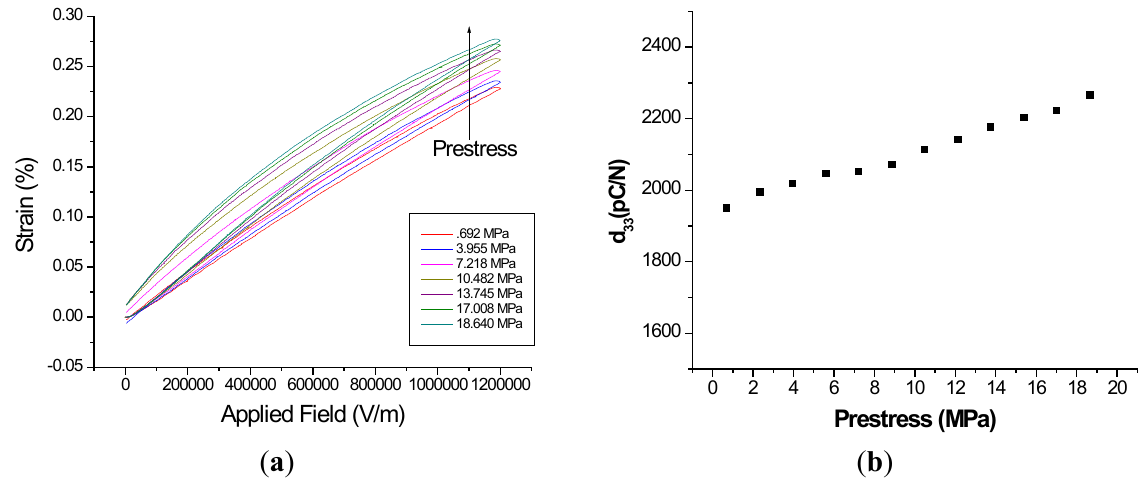
vs. prestress ( b ) under 33